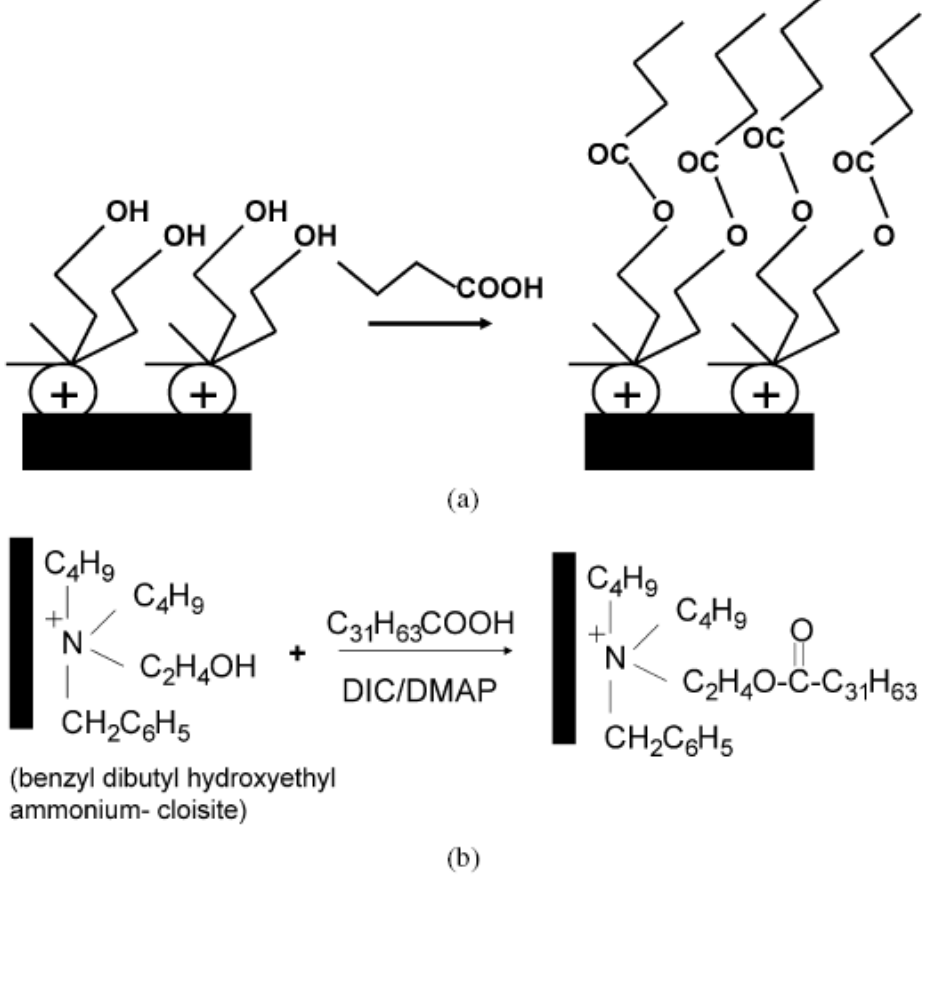
Figure 27. (a) Schematic of surface esterification reactions and (b) representation of the reaction with montmorillonite modified with benzyl dibutyl hydroxyethyl ammonium. Reproduced from reference [133] with permission from